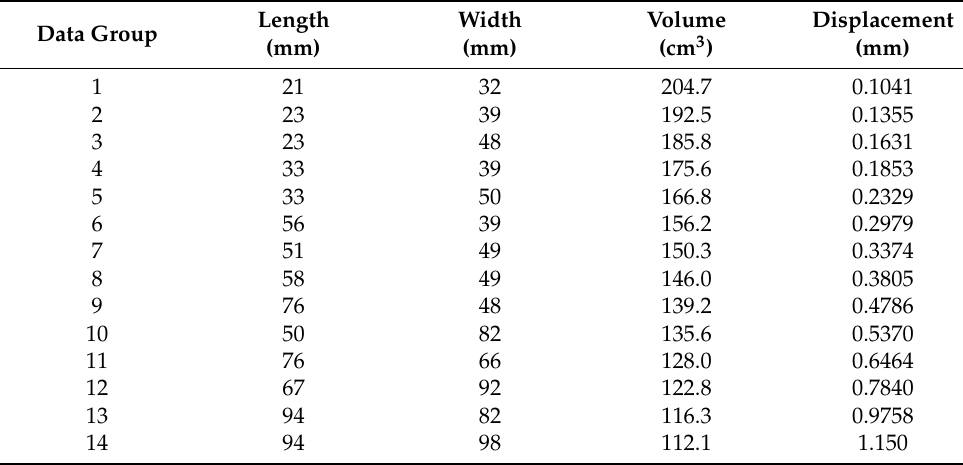
Figure 7. O-type optimization analysis results based on the HSA. Table 2. Numerical results based on the HAS for the O-type